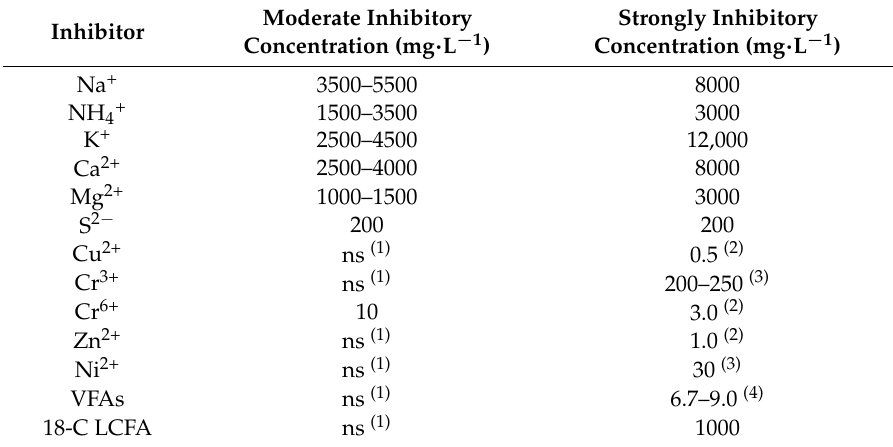
Table 8. The concentration of inhibitors that can affect AD